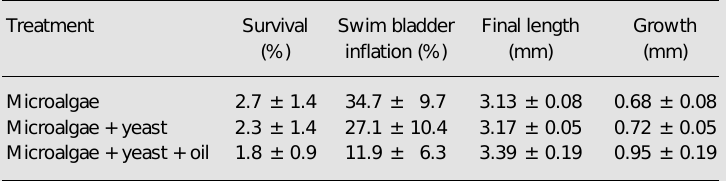
Table 2. Survival, swim bladder inflation, final standard length and growth of fat snook larvae reared for 14 days on rotifers fed different diets. Treatment